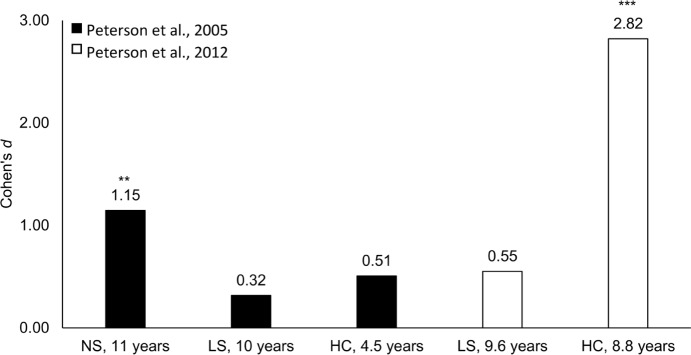
Effect sizes (Cohen’s d) for comparisons of index score on the Theory of Mind (ToM) scale of the present sample with that of selected groups of deaf native signing (NS), deaf late signing (LS), and hearing children (HC) from Peterson et al. (2005, 2012). The mean age of each comparison group is displayed next to the group label. ∗∗One-sample t-test, p < 0.01. ∗∗∗One-sample t-test, p < 0.001.